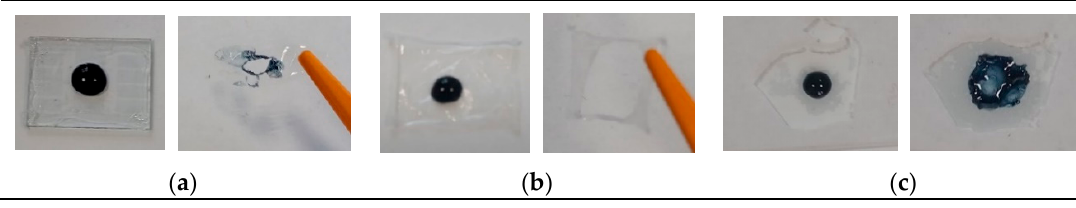
Figure 9. Thermal images for films composed of L,D-PLA, and PCL with SWCN at the ratio 10:0.5 w/w at 2.0 V, 6.0 V, and 10.0